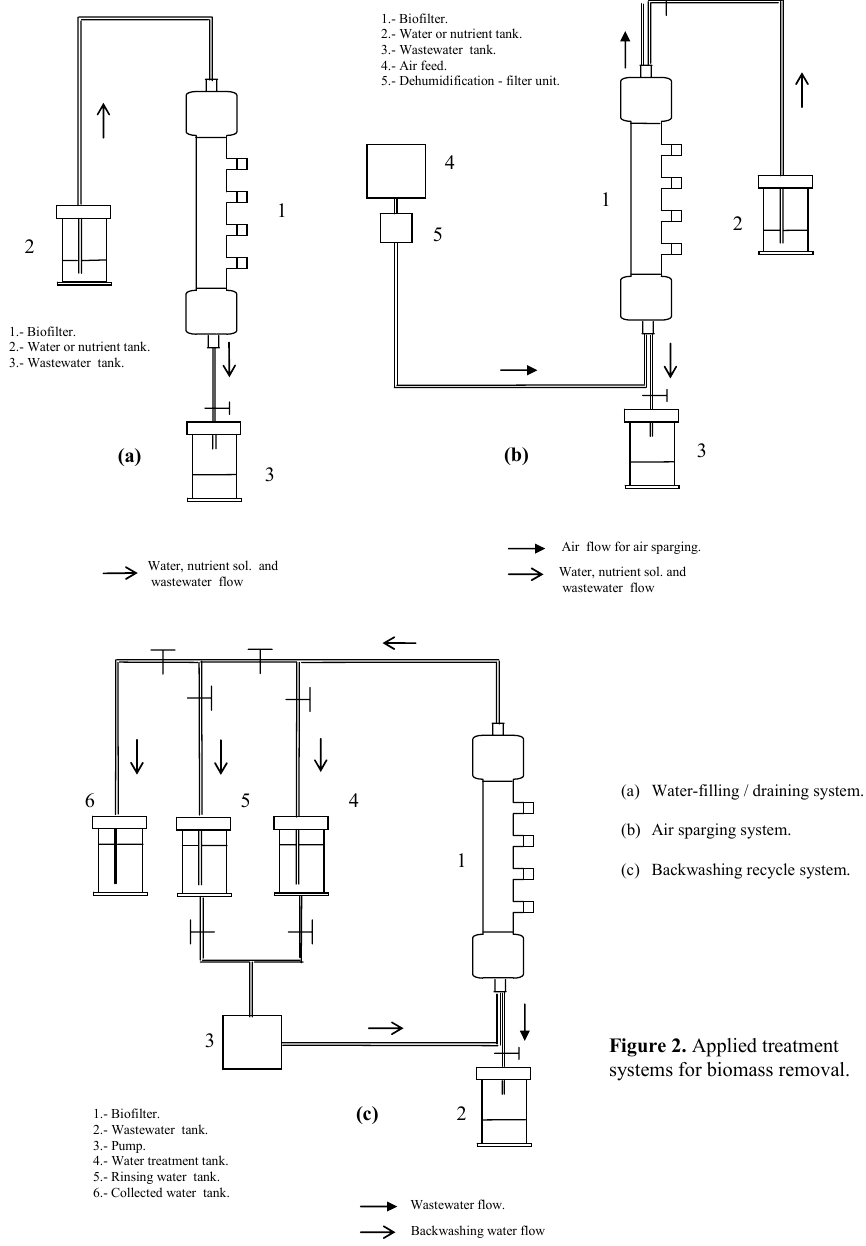
Figure 18. Applied treatment systems for biomass removal.